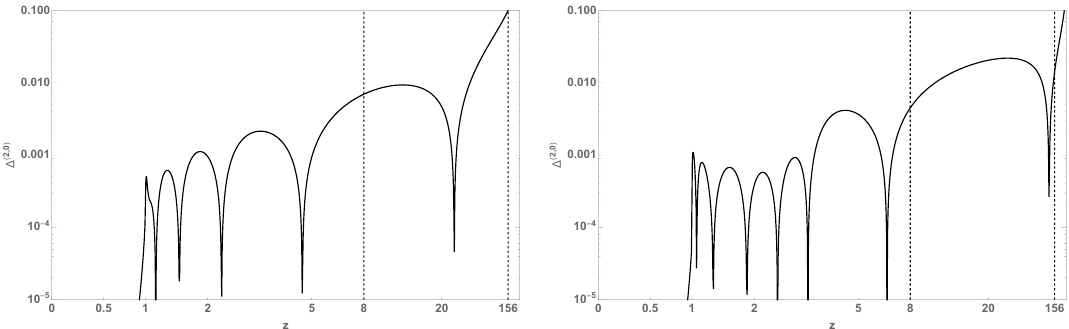
Figure 3 . Relative di(cid:11)erence, eq. (4.1), between the Pad(cid:19)e approximation of the three-loop coe(cid:14)- cient of the (cid:12)nite remainder C (2) from refs. [9] (left panel) and [26] (right panel) and the exact result I p at n l = 0, L (cid:22) = 0. z (cid:25) 8 corresponds to a s = 1 TeV Higgs boson produced through a top-quark loop, whereas z (cid:25) 156 corresponds to an on-shell Higgs boson produced through a b-quark loop.